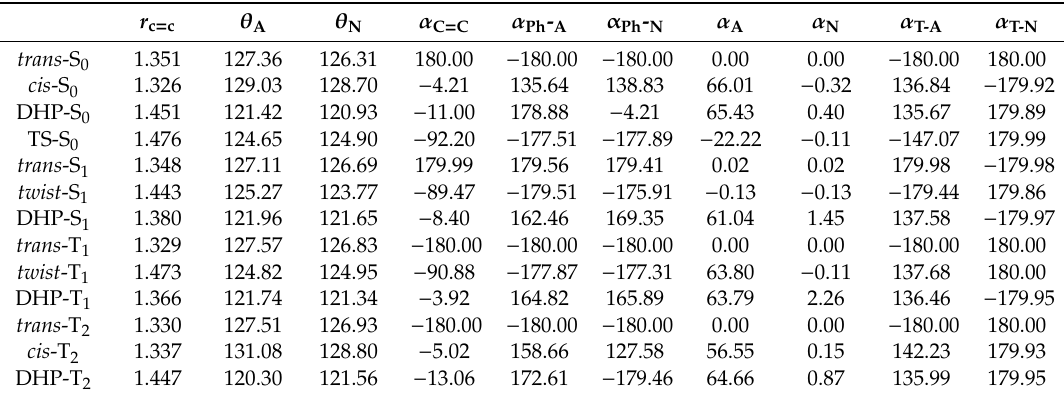
central double bond ( r c=c ), the bond angles toward inversion motion of the central double bond at amino ( θ A ) or nitro ( θ N ) side, and the dihedral angles corresponding to the torsion towards central nitro ( α N ) group and out-of-plane twisting of dimethylamino ( α T-A ) or nitro ( α T-N) group. Table 1. The SA6-CASSCF(18,12) / 6-31G* optimized internal coordinates for the trans -, cis -, twist -, TS-DANS and DHP. a.